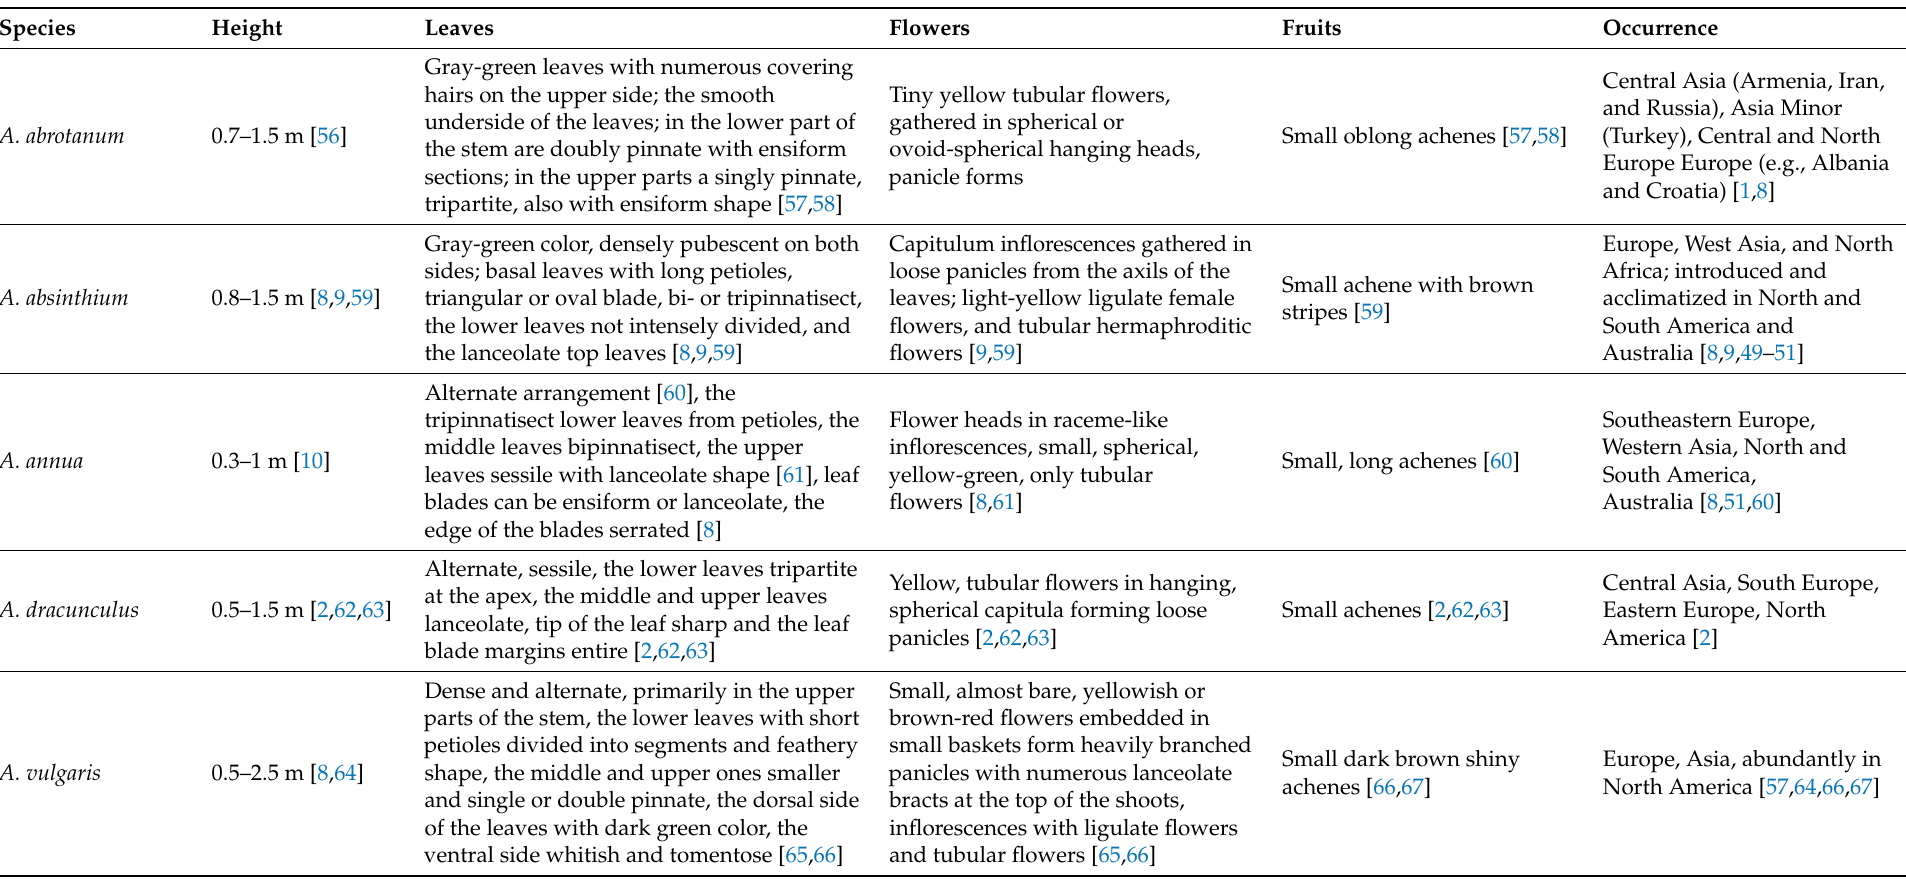
Table 1. Comparison of botanical characteristics and occurrence of Artemisia